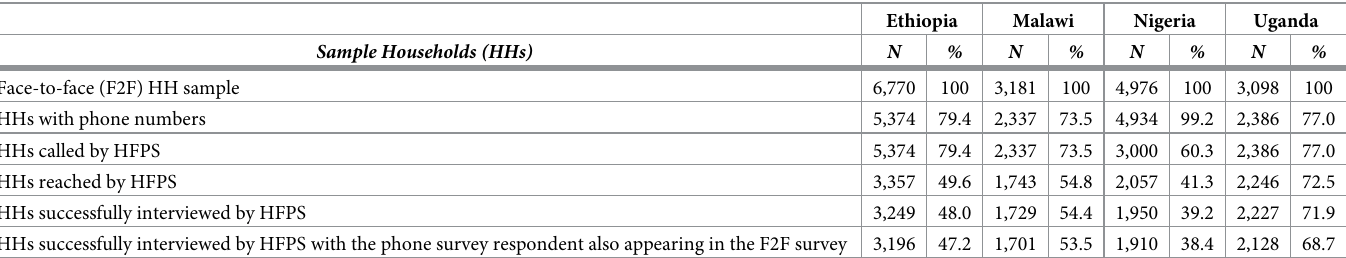
Table 1. Selection of HFPS households.